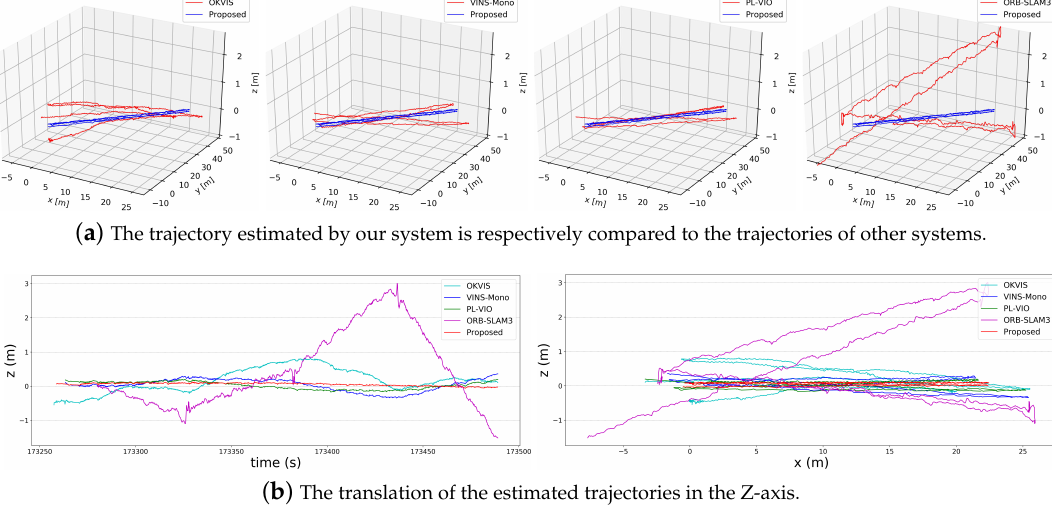
Figure 13. We show the estimated trajectories of other systems aligned with our trajectory and show the translation of the Z-axis of each system trajectory in time and space,